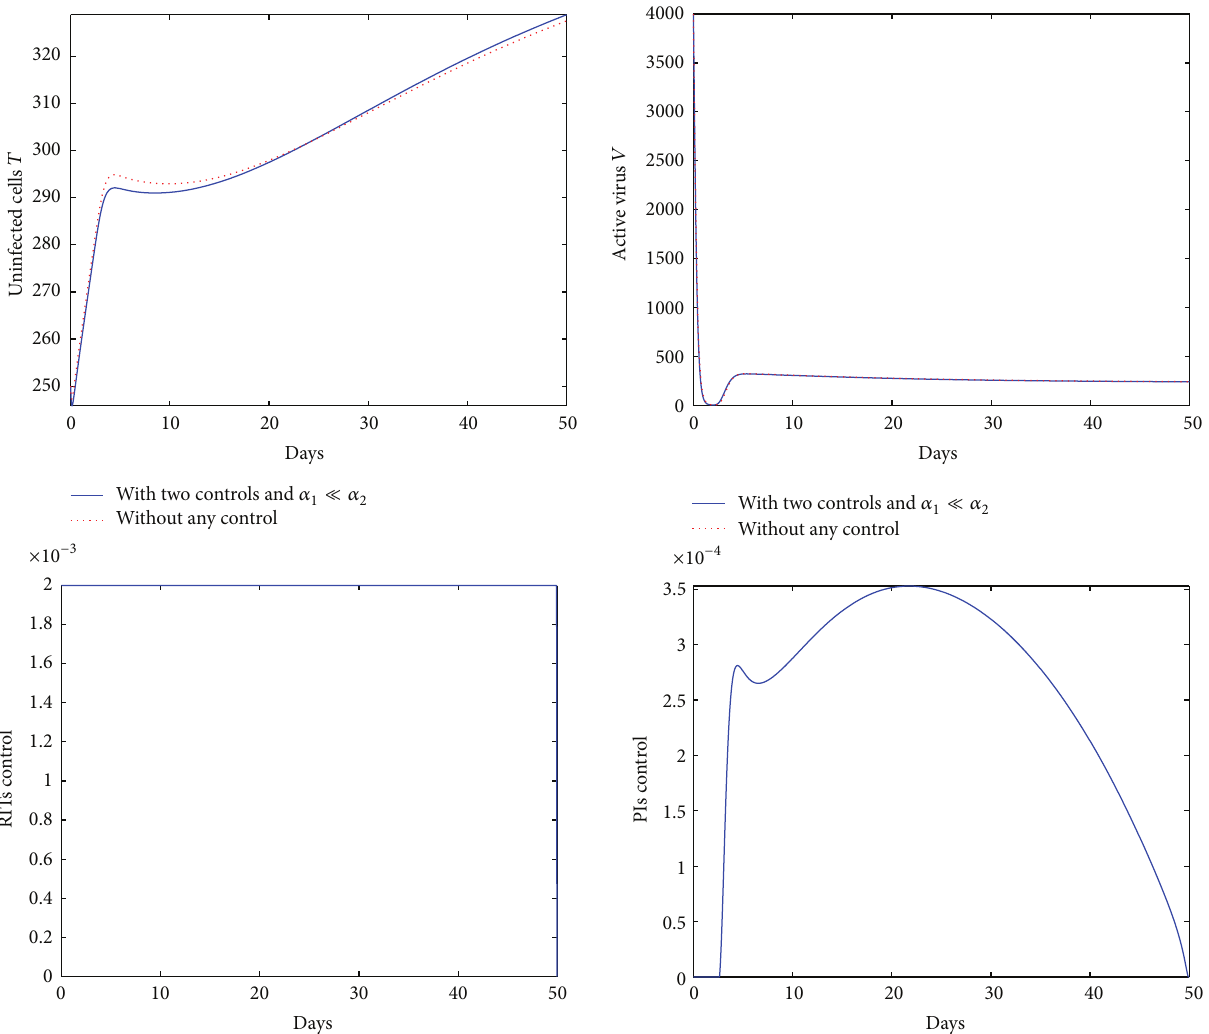
Figure 7: Optimal solutions using RTIs and PIs with 𝛼 1 ≪ 𝛼 2 for a 50-day